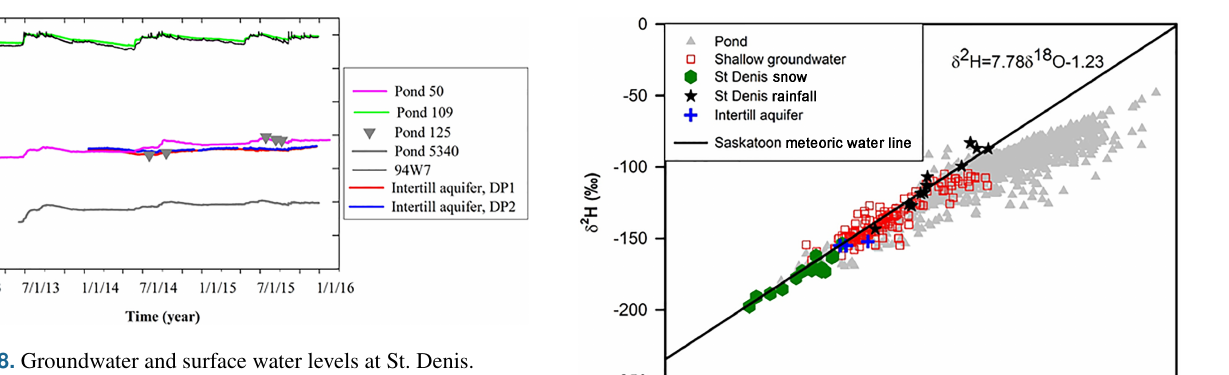
Figure 8. Groundwater and surface water levels at St. Denis.